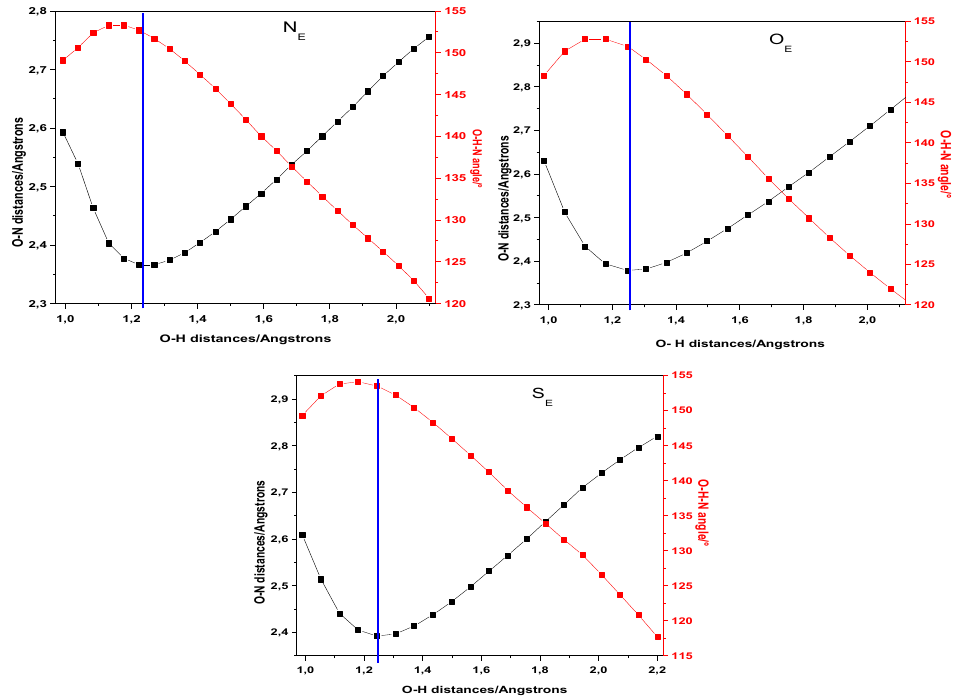
Figure 3. Variation of O–N distance (in black, left y-axis) and O–H ··· N angle (in red, right y-axis) for N E , O E , and S E with changes on the O–H distance. The blue line indicates in which O–H distance the proton is transferred.